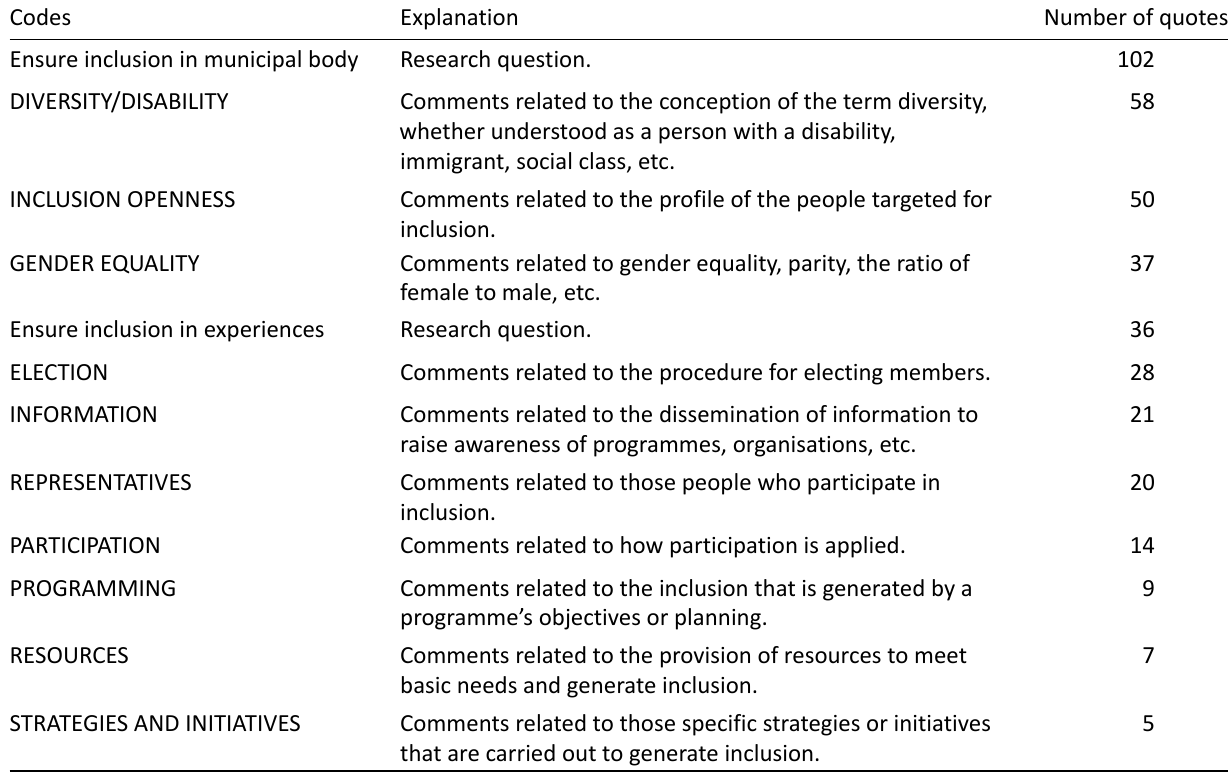
Table 1. Resulting categories.